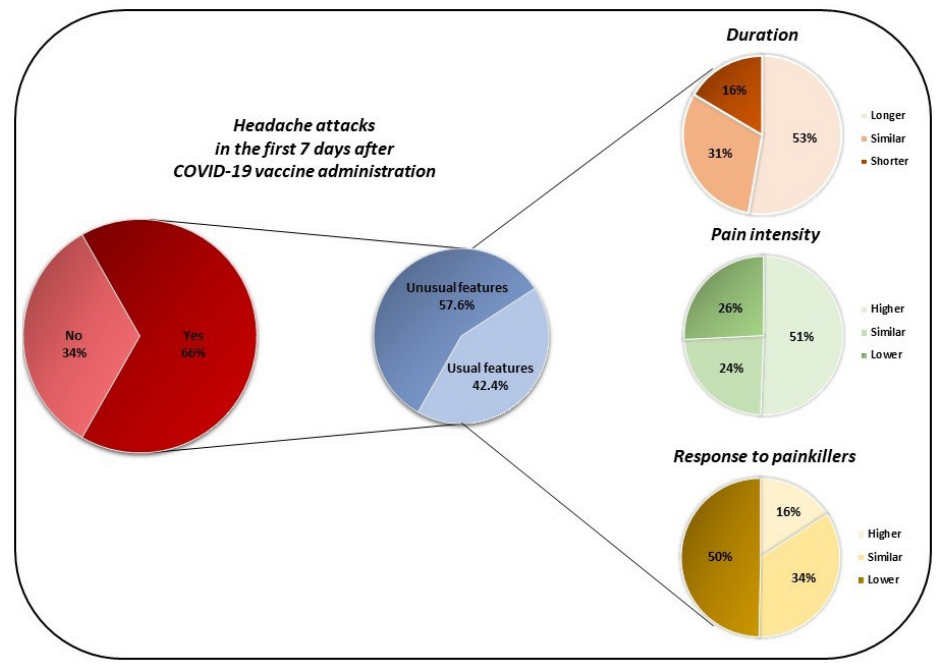
Figure 1. Features of headache attacks occurring in the first 7 days after the first COVID-19 vaccine administration.